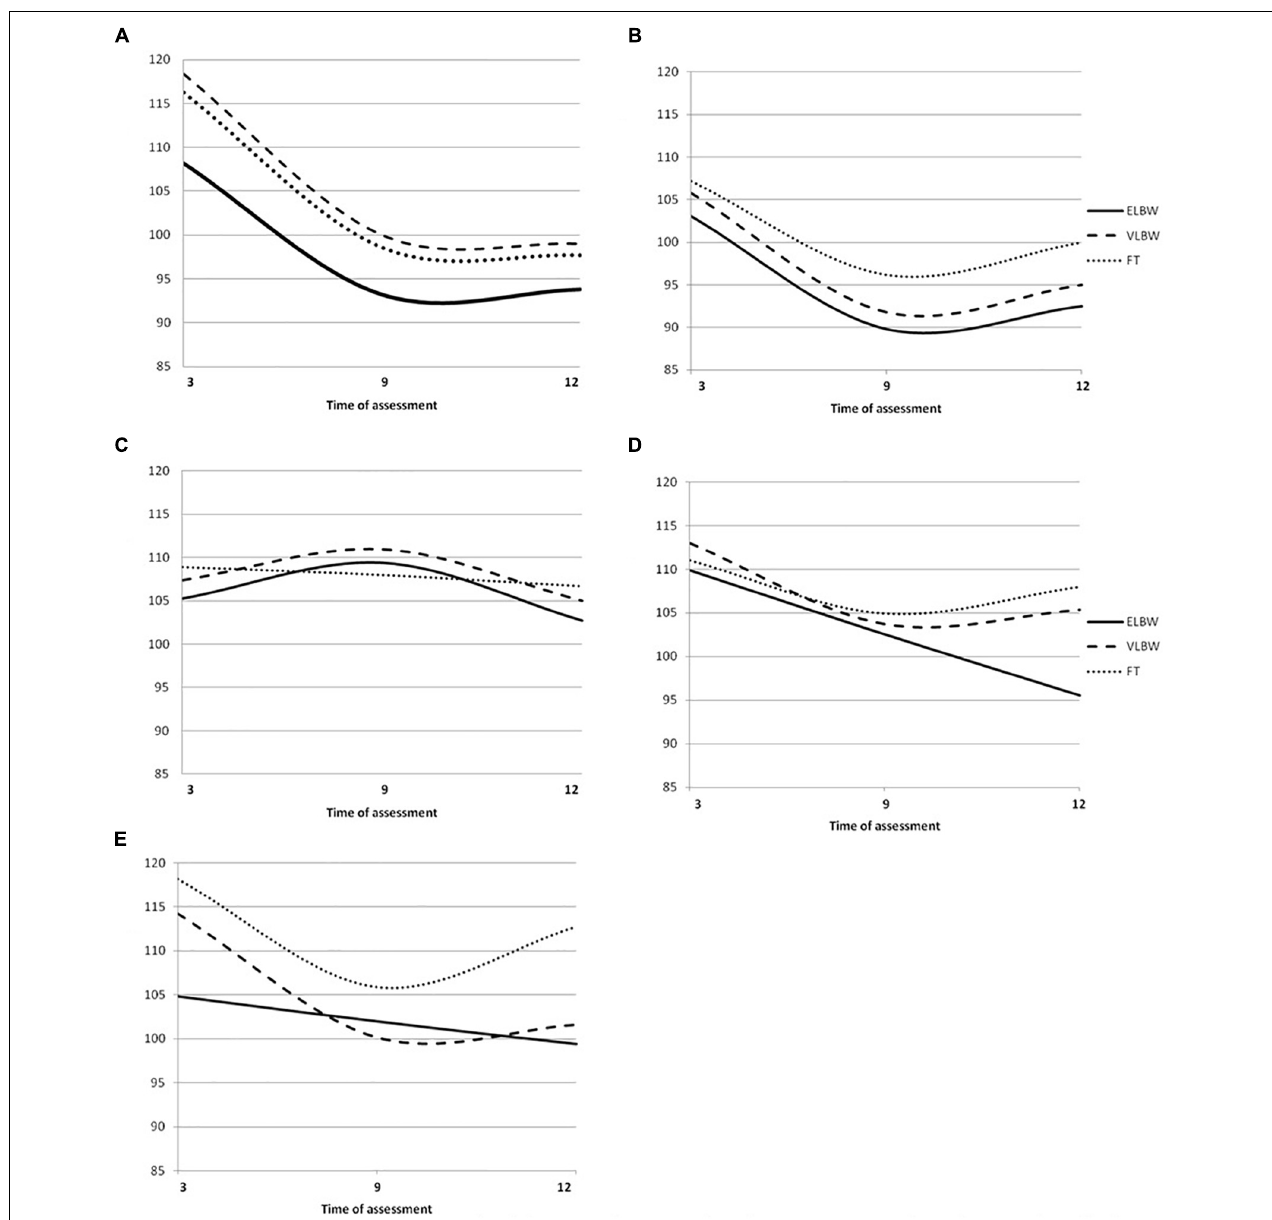
FIGURE 3 | Griffiths Mental Development Scales quotient growth trajectories in ELBW. VLBW and FT infants. (A) Locomotor mean Quotients, (B) Ferscnal-Social mean Quotients, (C) Hearing and Language mean Quotients; (D) Eye-Hand Coordination mean Quotients; (E) Performance mean Quotients Continue line denotes ELBW group; dashed line VLBW group; dotted line FT